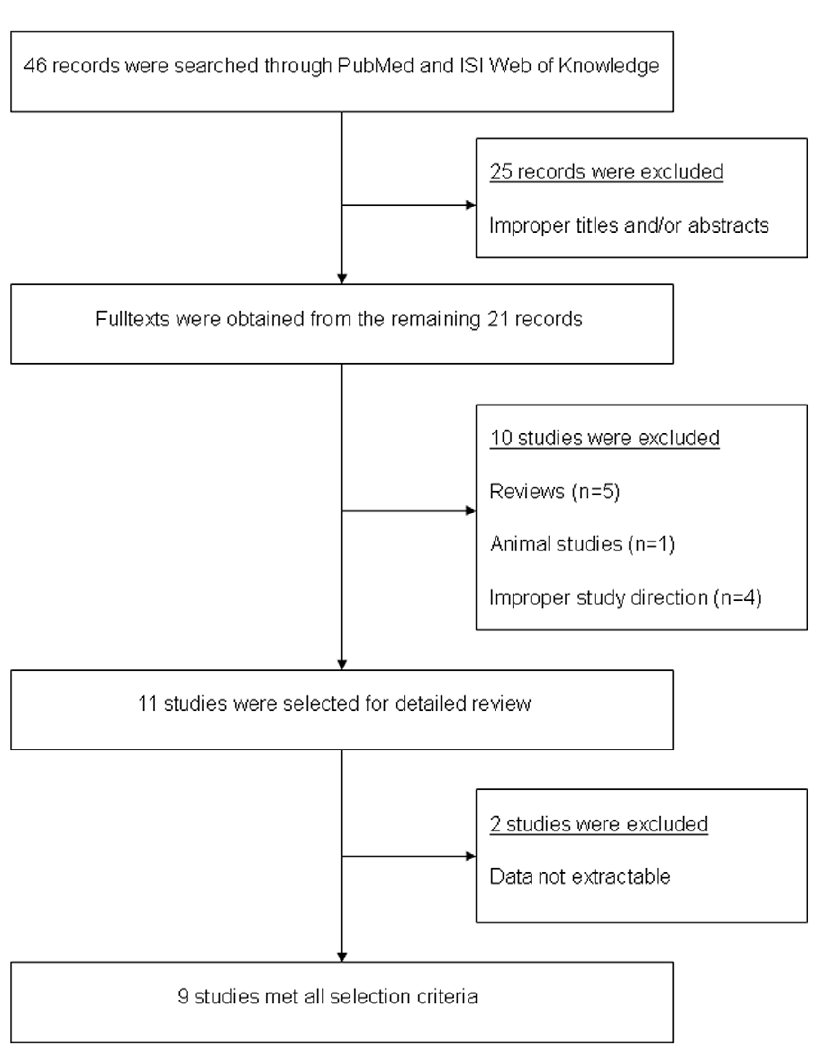
Figure 1. Selection process for study inclusion in the meta-analysis of CCL3L1 CNV and HIV-1 susceptibility.